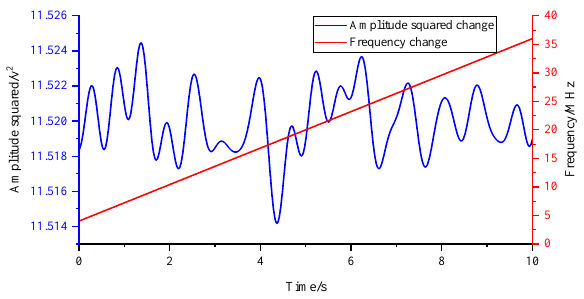
Figure 16. The amplitude of the quadrature signal whose frequency varies from 4 to 36 MHz after passing through the dynamic